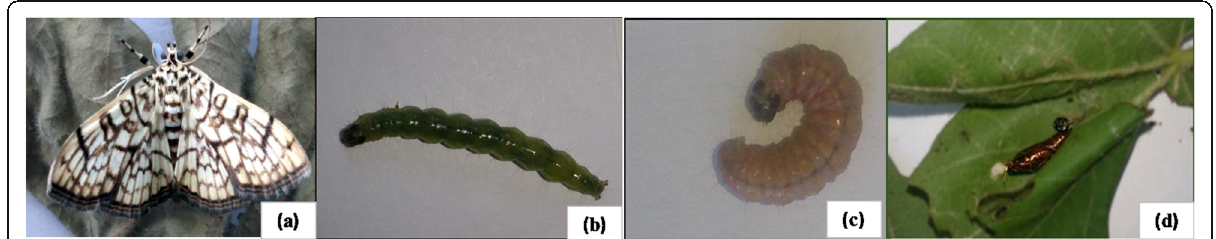
Fig. 1 Different stages of Syllepte derogata a adult, b larvae, c larvae before pupation, and d